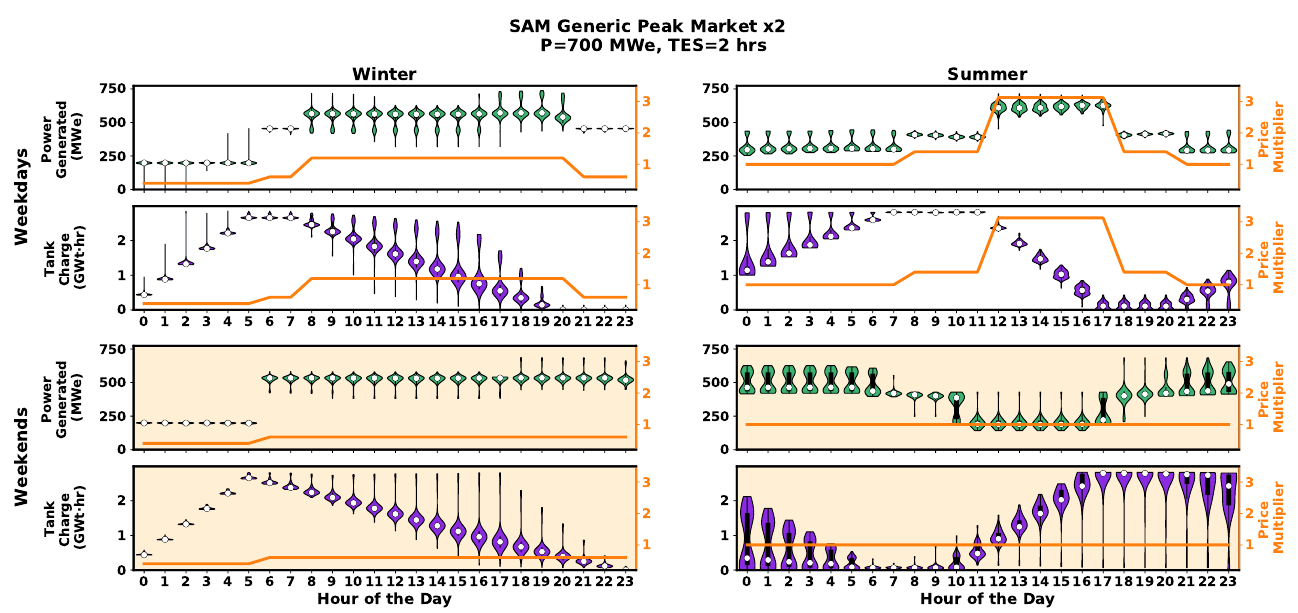
Figure 5. Hourly violin plot distributions for a year of simulated electric power and stored energy levels. Computed for a 700 MW e turbine with 2 h of TES under twice-amplified SAM generic peak market prices. Median value for each hour is shown as a white circle and the black vertical rectangle demarcates 25th and 75th percentiles. Distributions are split between winter and summer price schedules as well as weekday and weekend prices; price multipliers are shown on the right